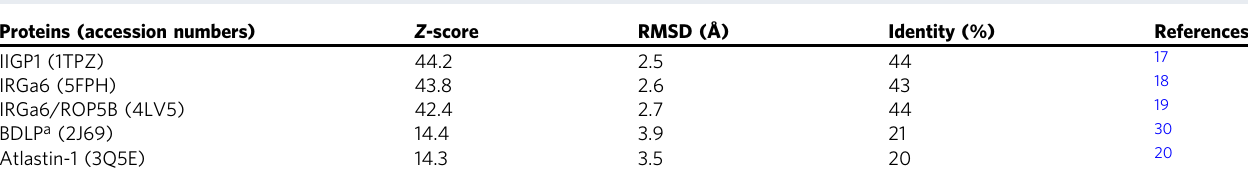
Fig. 3 Dimeric structure of IRGB10. a Details of the interface formed by the head-to-head dimer. Cartoon representation of the head-to-head dimer (left panel) with a close-up view of the main interface (right panel). Black dotted lines and red dotted lines indicate hydrogen bonds and salt bridges, respectively. b Details of the interface formed by the head-to-tail dimer. Cartoon representation of the head-to-tail dimer (left panel) with a close-up view of the main interface (right panel). Black dotted lines and red dotted lines indicate hydrogen bonds and salt bridges, respectively. c and d SEC pro fi les comparing the position of eluted peaks between wildtype IRGB10 and either ( c ) head-to-head dimer disruption mutants (D185R and K193E), or ( d ) head- to-tail dimer disruption mutants (T132W and E206K). e and f SEC-MALS analysis of newly produced peaks by D185R mutation. The tentative dimer peak ( e ) and monomer peak ( f ) were analyzed by MALS. g and h SEC-MALS analysis of newly produced peaks by K193E mutation. The tentative dimer peak ( g ) and monomer peak ( h ) were analyzed by MALS. Table 2 Structural similarity search using Dali 29